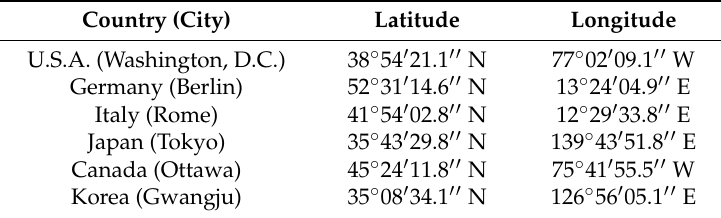
Table 5. The latitude and longitude of representative cities and countries.